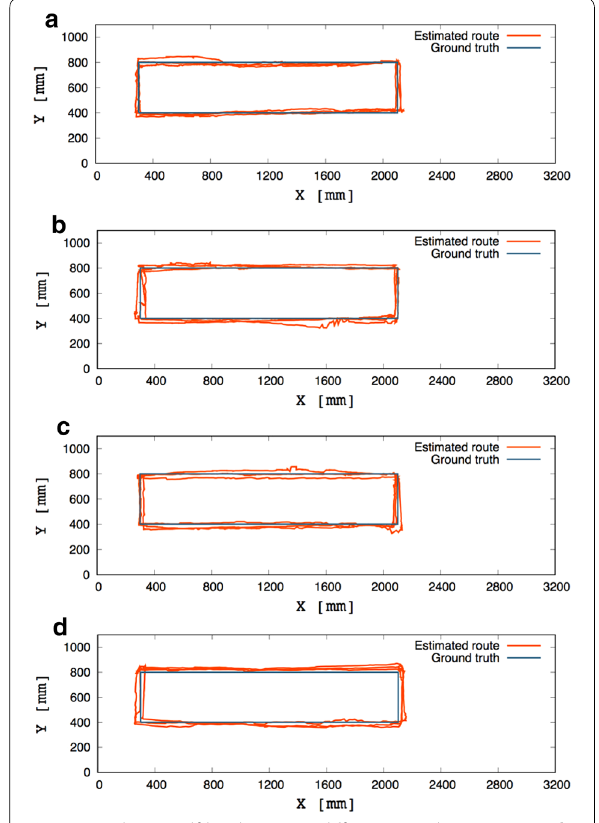
Fig. 13 Real-time self-localization at different speeds: a 100 mm/s; b 150 mm/s; c 250mm/s; d 300